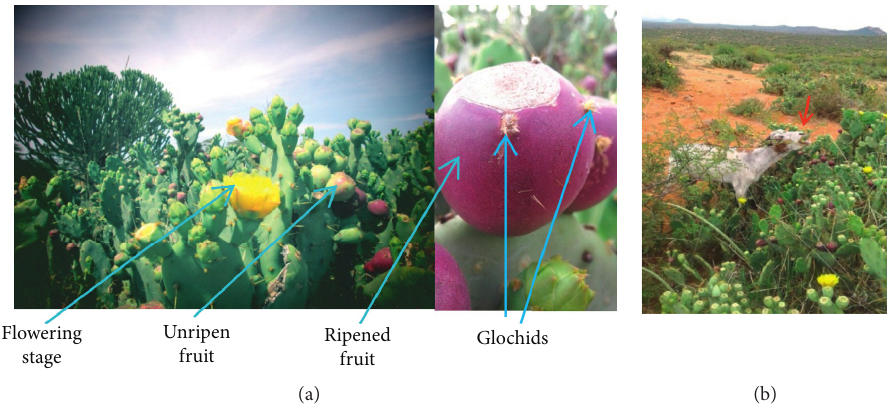
Figure 1: Opuntia stricta in Laikipia County rangelands (a) showing fruits at various stages of development and hairy thorns (glochids) on the fruits. A goat browsing (red arrow) on fruits of Opuntia stricta in Laikipia North sub-County